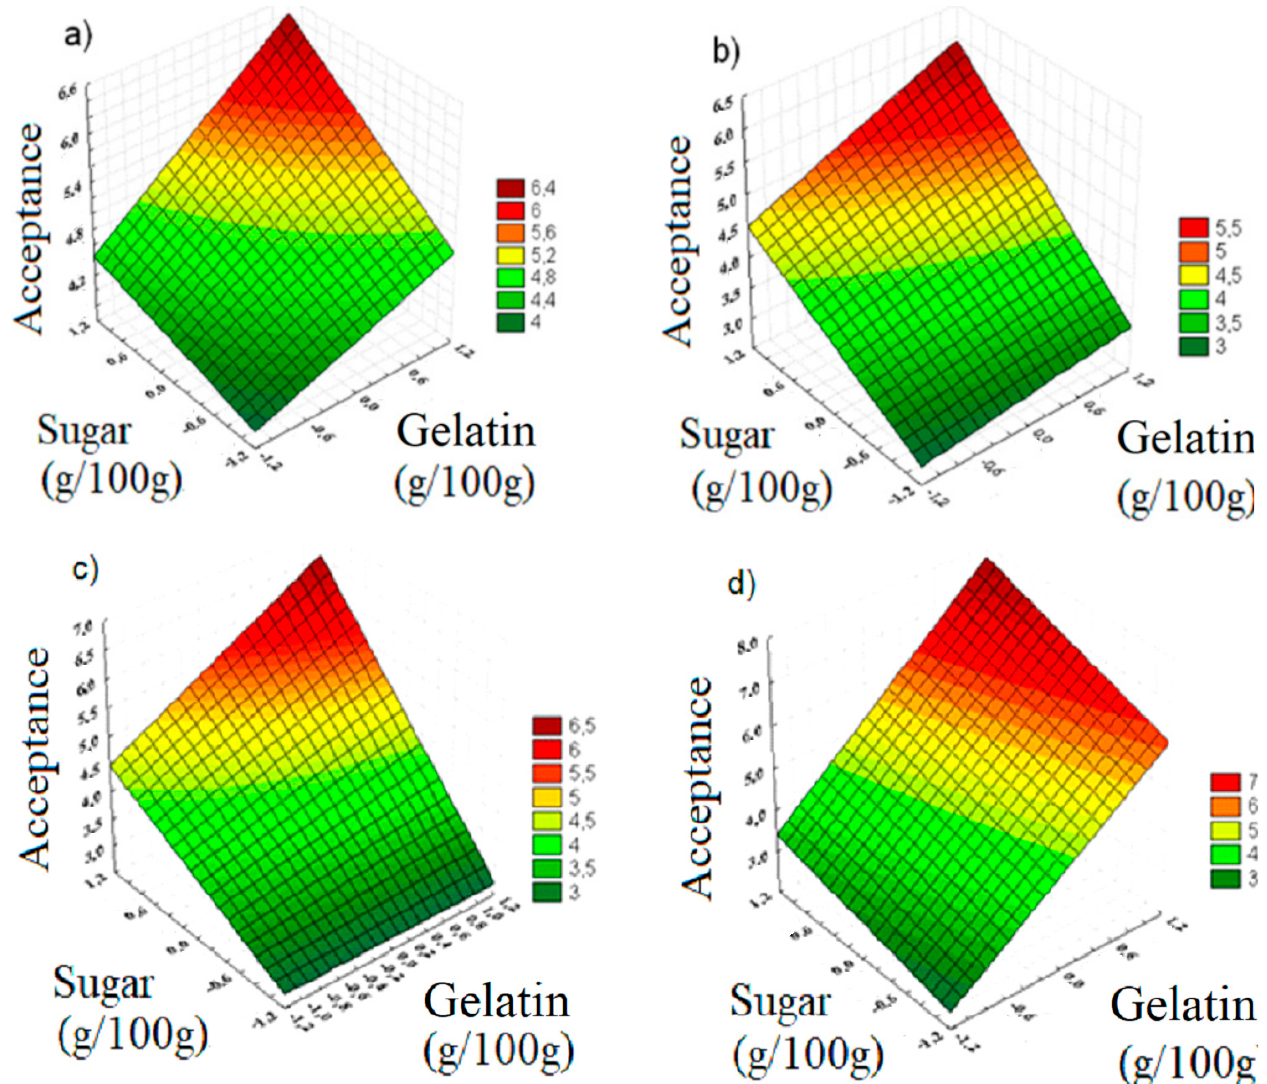
Figure 6. Response surfaces to optimise the gelatin-base gel attributes: ( a ) colour, ( b ) flavour, ( c ) aroma, and ( d ) texture .